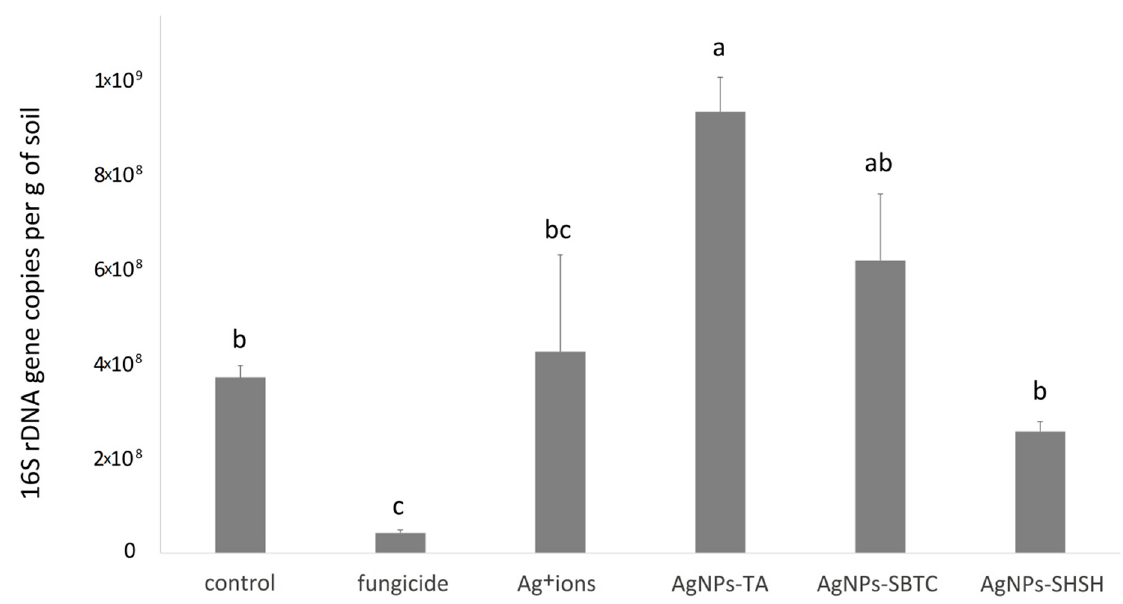
Figure 2. Average bacterial load in soil for experimental treatments after 7 days incubation. The values with the same letter are not significantly different ( p =0.05).